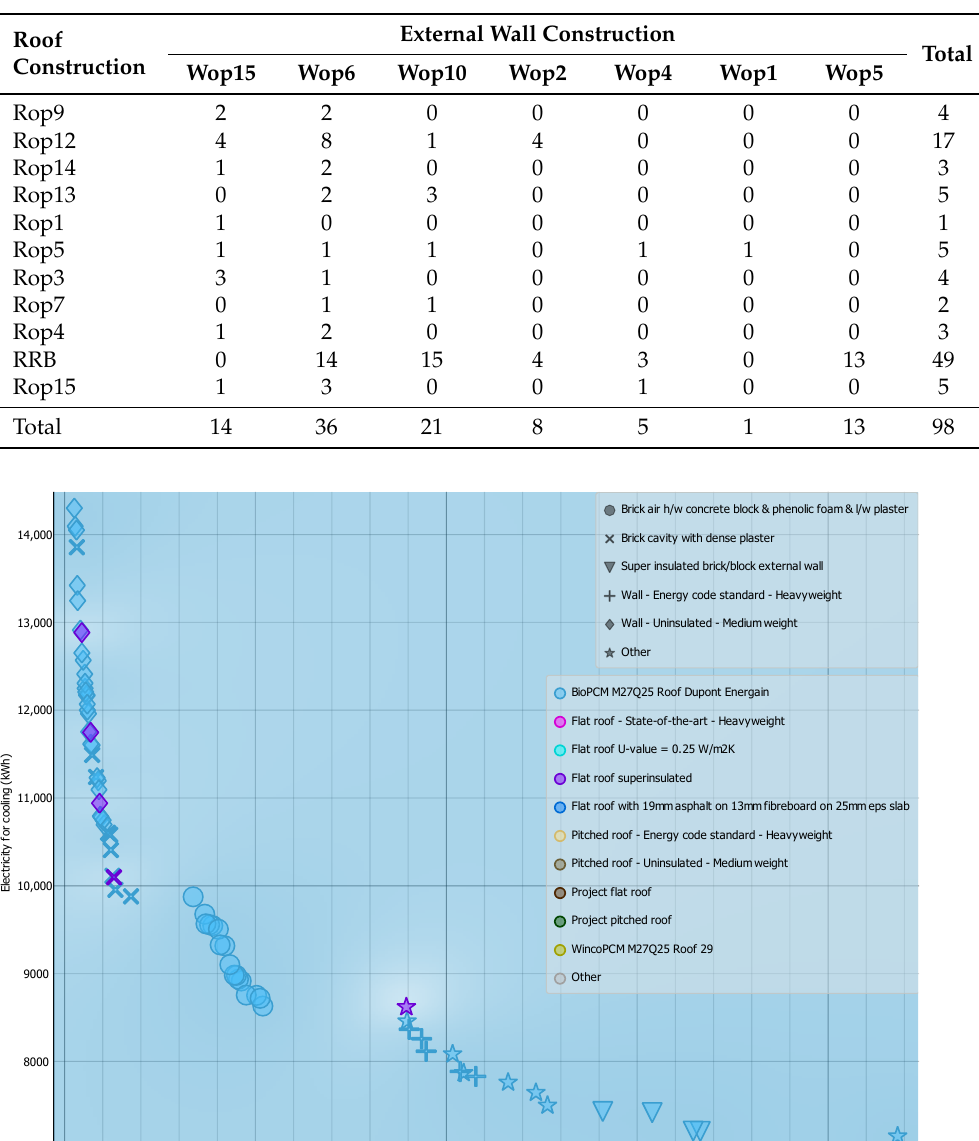
Table 6. Resulting counts of each layout combination that appeared at Pareto’s front for the 100 m 2 building.